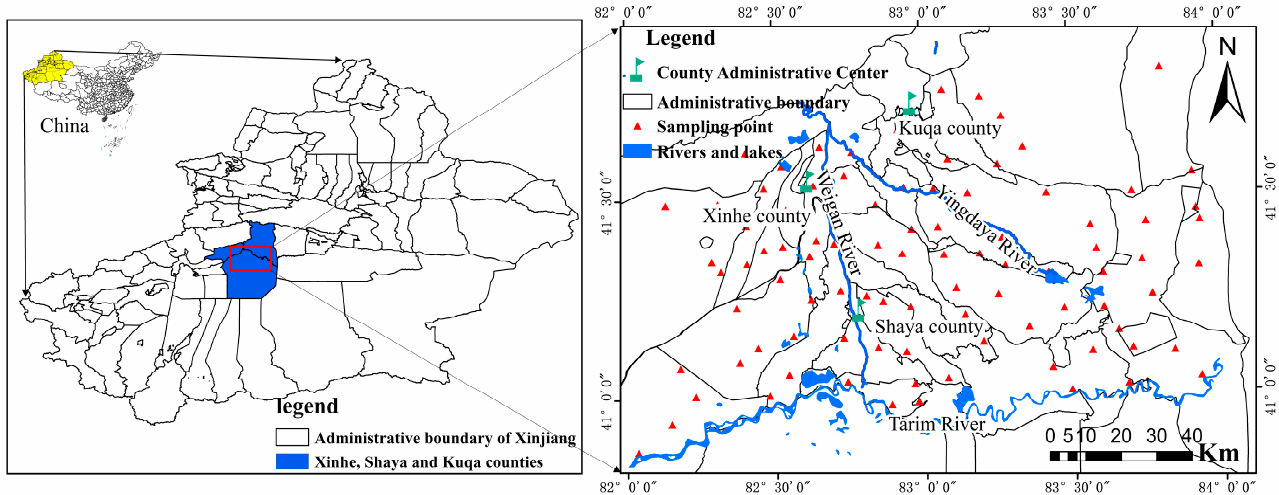
Figure 2. Location of study area and distribution of sampling points.